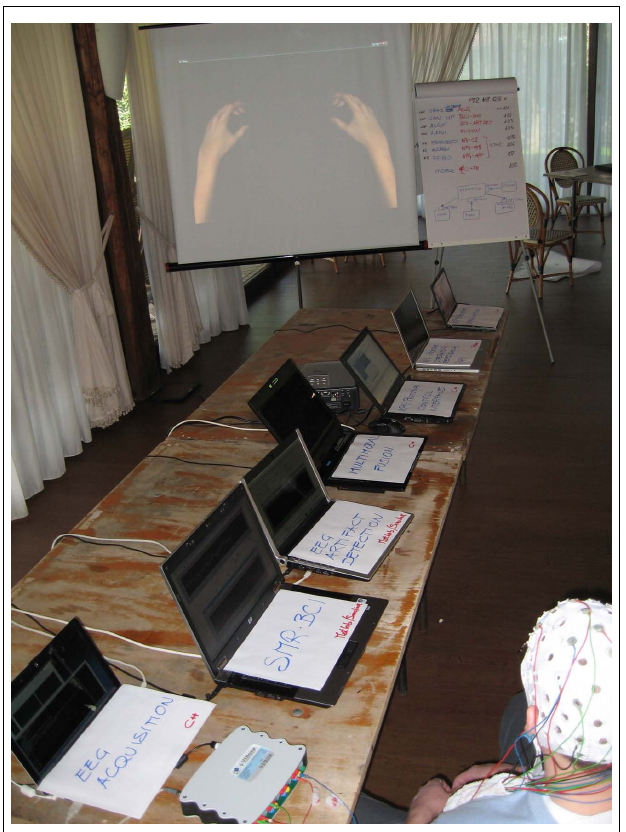
FIGURE 7 |This picture was taken during the demonstration of the proof of concept. Here, all connected computers, forming a demo hybrid BCI, are visible.The first was used for data acquisition, running the SignalServer, and the next two were used to build an SMR BCI and an artifact detection. Laptop number four was a very simple implementation of fusion. Laptops five and seven formed together the visual feedback, presented on the screen (control interface and feedback application).The sixth laptop showed an additional operator feedback which was not presented to the